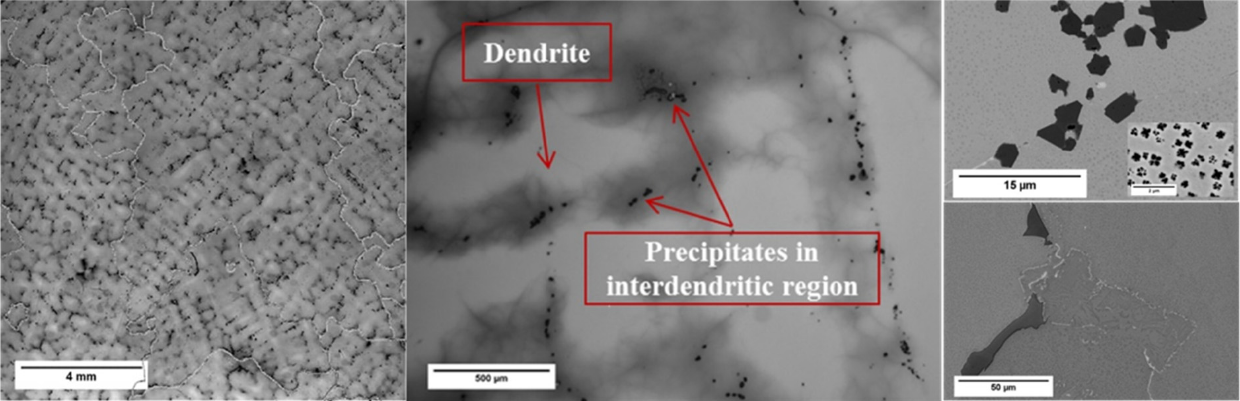
Figure 3. Microstructural overview of the AC sample. From left to right: an overview of huge grains and dendrites; interdendritic precipitates; randomly distributed MX precipitates and blocky grain boundary MX precipitates. The inserted image is a micrograph of γ ’.